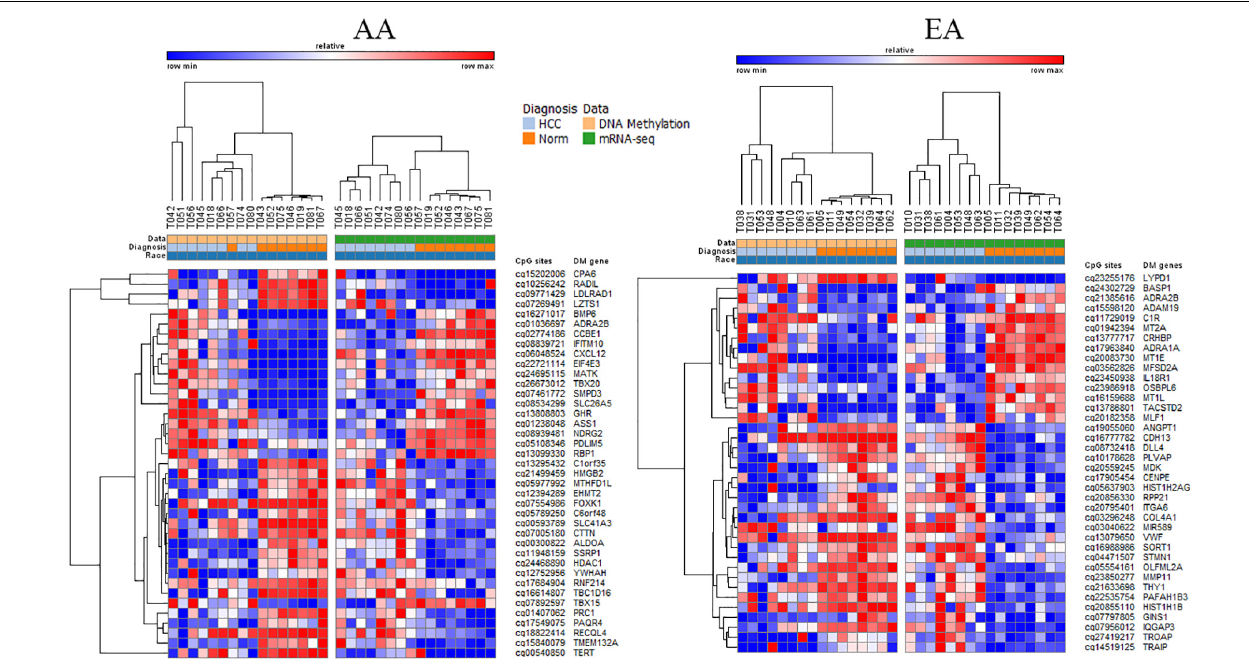
FIGURE 4 | DMDE genes selected by integrative analysis of DNA methylation and mRNA or miRNA expression data. DMDE genes specific to AA (left) and specific to EA (right).